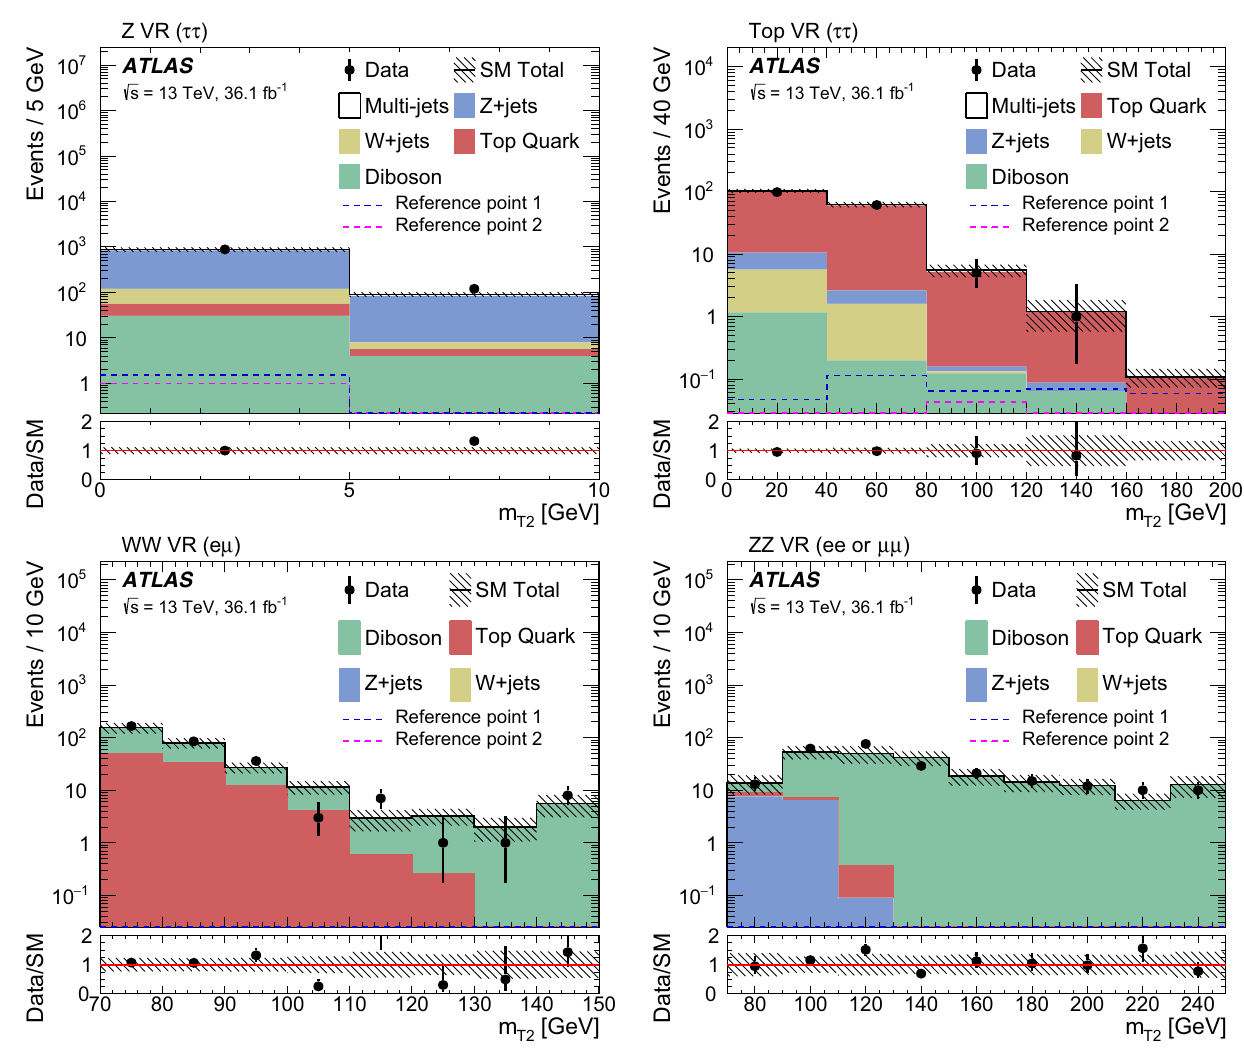
Fig. 5 The m T2 distributioninthe Z -VR(topleft),Top-VR (topright), WW -VR (bottom left) and Z Z -VR (bottom right) regions. The SM backgrounds other than multi-jet production are estimated from MC simulation. The multi-jet contribution is negligible and not considered in WW -VR and Z Z -VR, while in Z -VR and Top-VR it is estimated from data using the ABCD method, using CRs obtained with the same